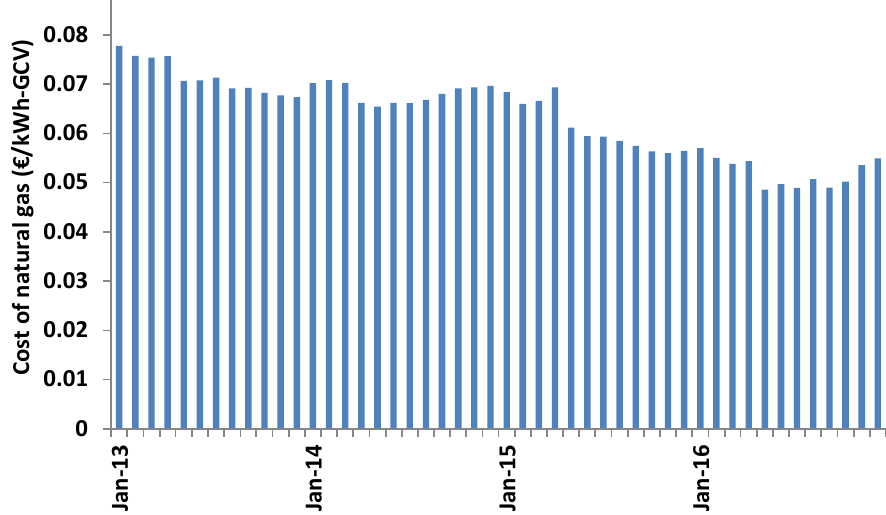
Figure 11. Variation of natural gas prices in Greece, during last three years.